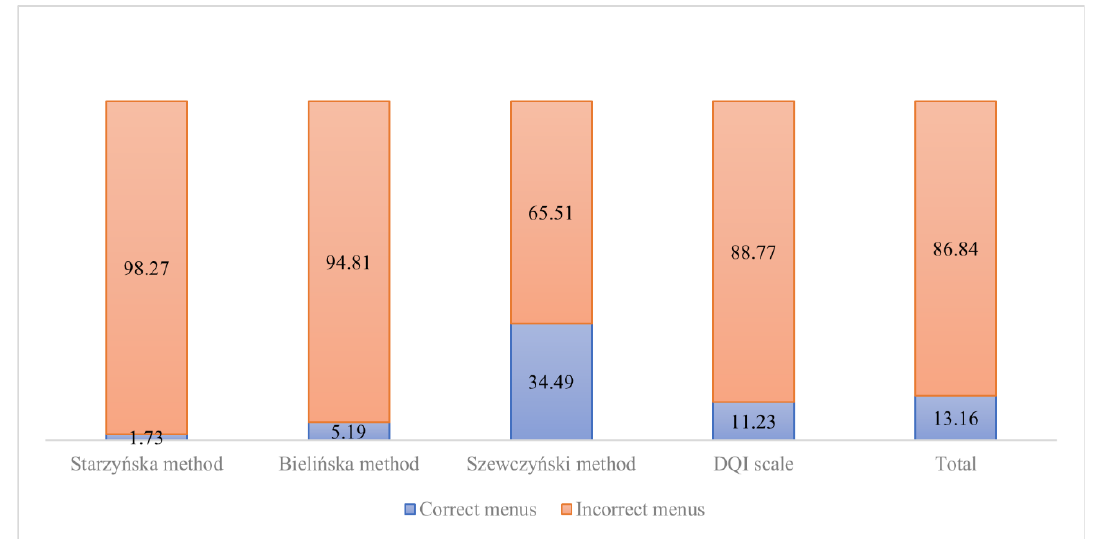
Figure 3. Qualitative evaluation of menus.